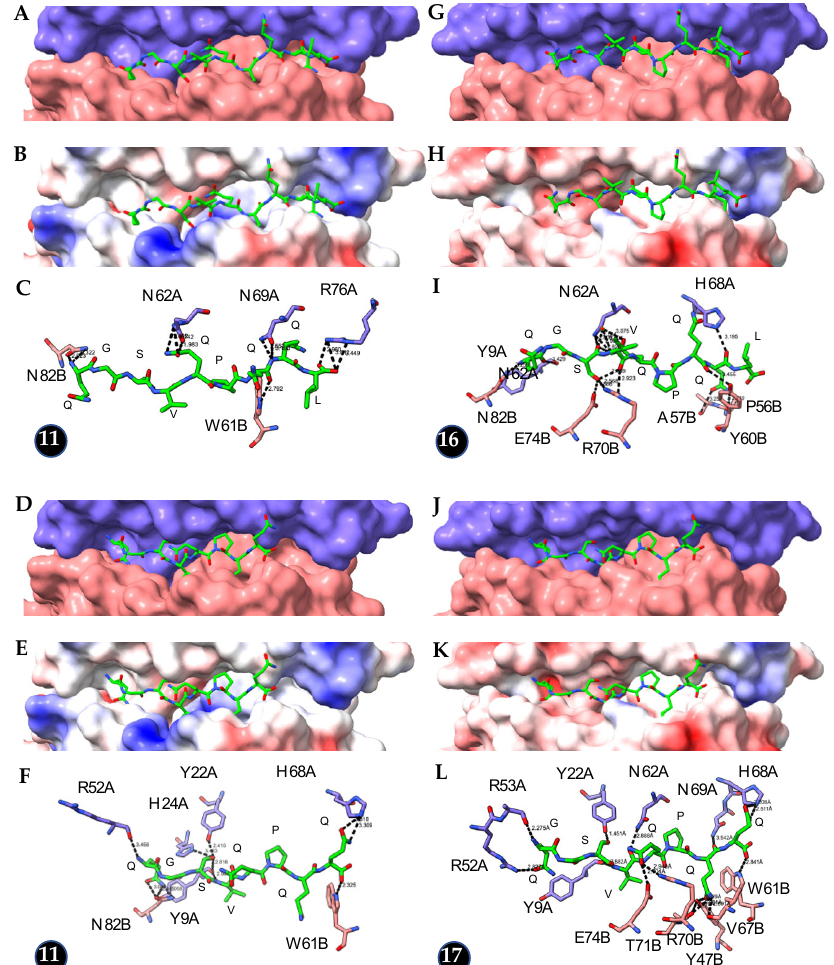
Figure 8. ( A – C ): ( A ). Docking of the DQ8 ‐ specific QGSVQPQQL peptide (colored green) to the basket of HLA ‐ DQ2 (PDB code 1S9V). The A and B domains forming the HLA ‐ DQ2 basket are colored violet and pink, respectively. ( B ). Coulombic surfaces (acidic in red, basic in blue, neutral in white) of the basket. ( C ). Network of hydrogen bonds (dashed black lines) connecting the peptide to the amino acid residues of the A and B domains, labeled and colored violet and pink, respectively. ( D – F ): ( D ). Docking of the truncated QGSVQPQQ peptide (colored green) to the basket of HLA ‐ DQ2 (PDB code 1S9V). The A and B domains forming the HLA ‐ DQ2 basket are colored violet and pink, respectively. ( E ). Coulombic surfaces (acidic in red, basic in blue, neutral in white) of the basket. ( F ). Network of hydrogen bonds (dashed black lines) connecting the truncated peptide to the amino acid residues of the A and B domains, labeled and colored violet and pink, respectively. ( G – I ): ( G ). Docking of the DQ8 ‐ specific QGSVQPQQ peptide (colored green) to the basket of HLA ‐ DQ8 (PDB code 4GG6). The A and B domains forming the HLA ‐ DQ8 basket are colored violet and pink, re ‐ spectively. ( B ). Coulombic surfaces (acidic in red, basic in blue, neutral in white) of the basket. ( C ). Network of hydrogen bonds (dashed black lines) connecting the peptide to the amino acid residues of the A and B domains, labeled and colored violet and pink, respectively. ( J – L ): ( J ). Docking of the DQ8 ‐ specific truncated QGSVQPQQ peptide (colored green) to the basket of HLA ‐ DQ8 (PDB code